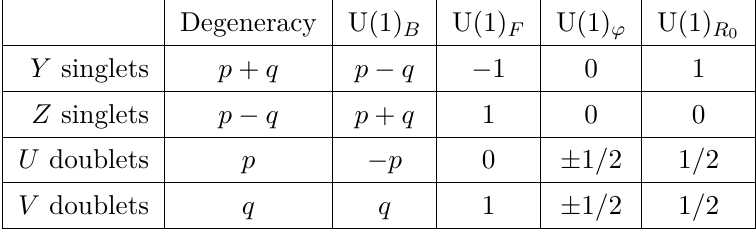
Table 1. Field content for the infinite family of Y p,q quiver gauge theories. See, e.g.